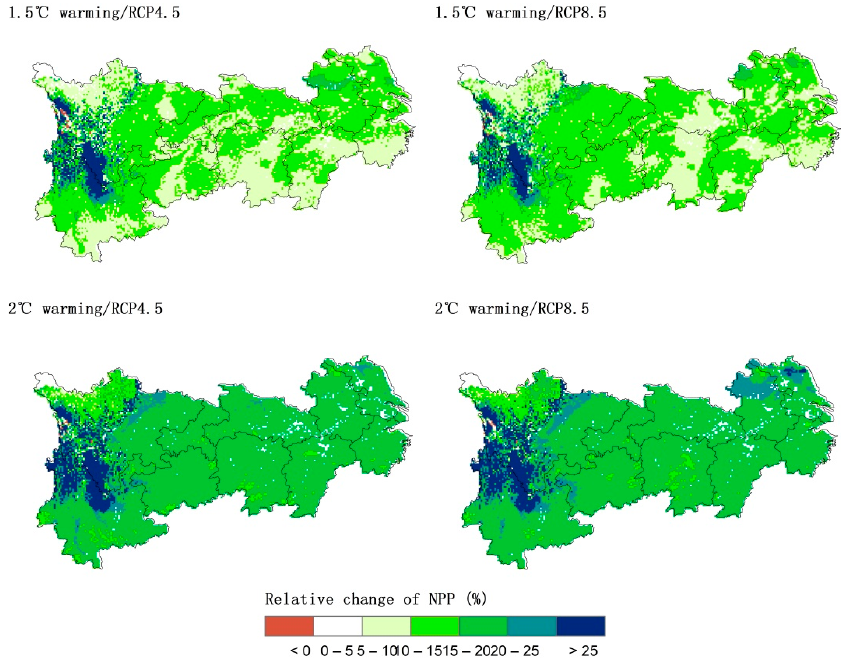
Figure 7. Spatial patterns of vegetation NPP at 1.5 and 2 °C global warming under the RCP4.5 and RCP8.5 scenarios in the YREB.